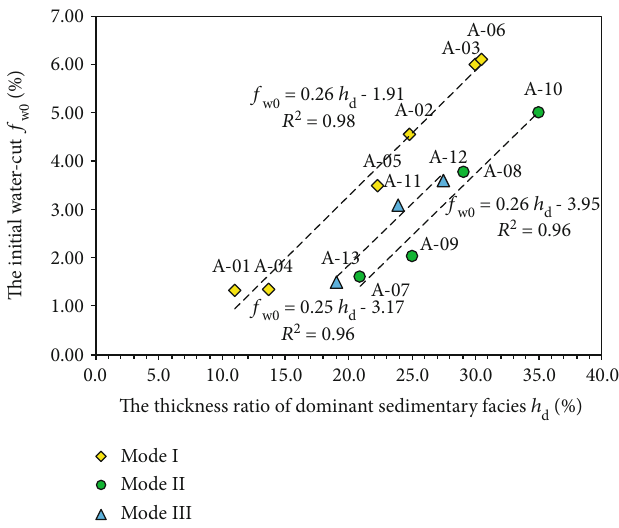
Figure 7: The relationship between f